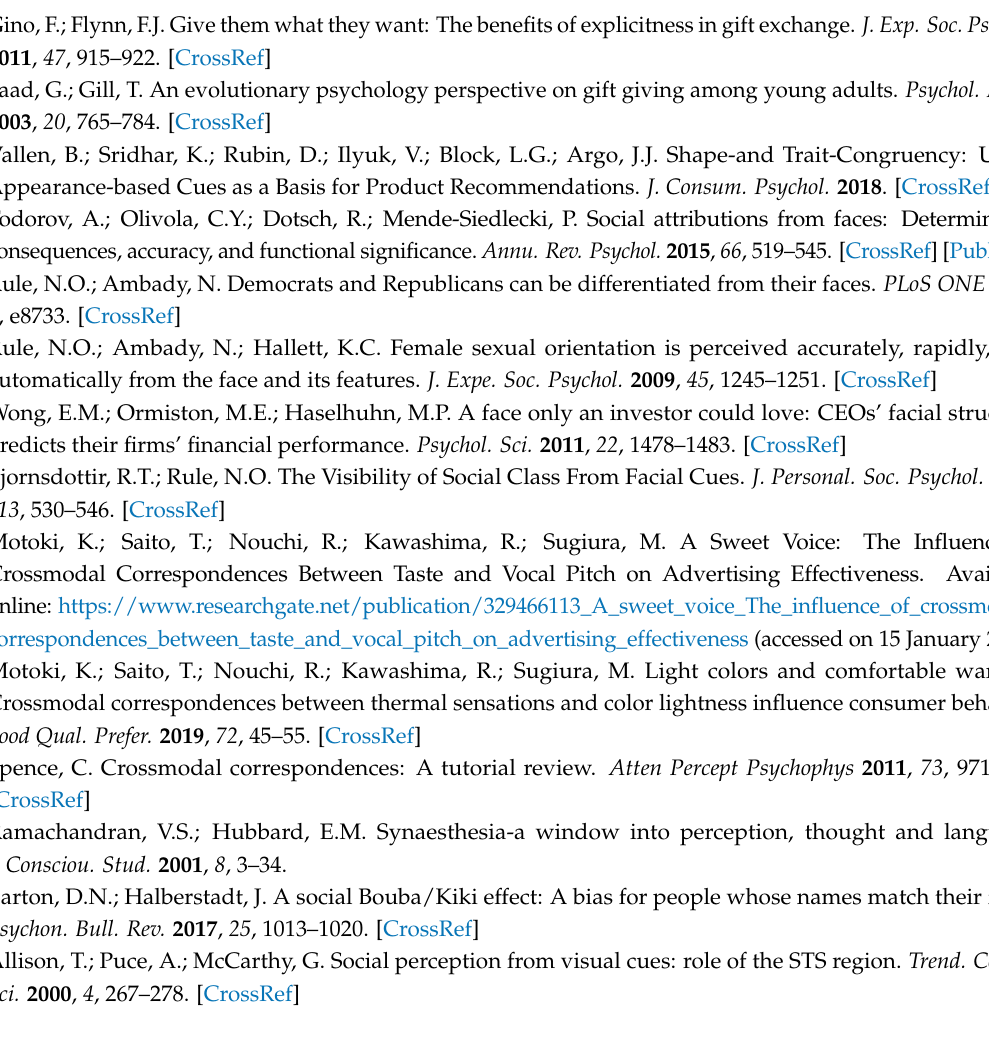
Figure A5. The correlation matrix; all measures showed positive correlations.